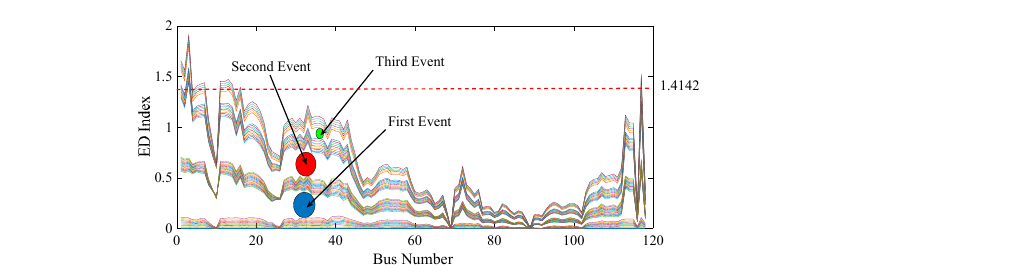
mand steps for the IEEE 118-bus test system.